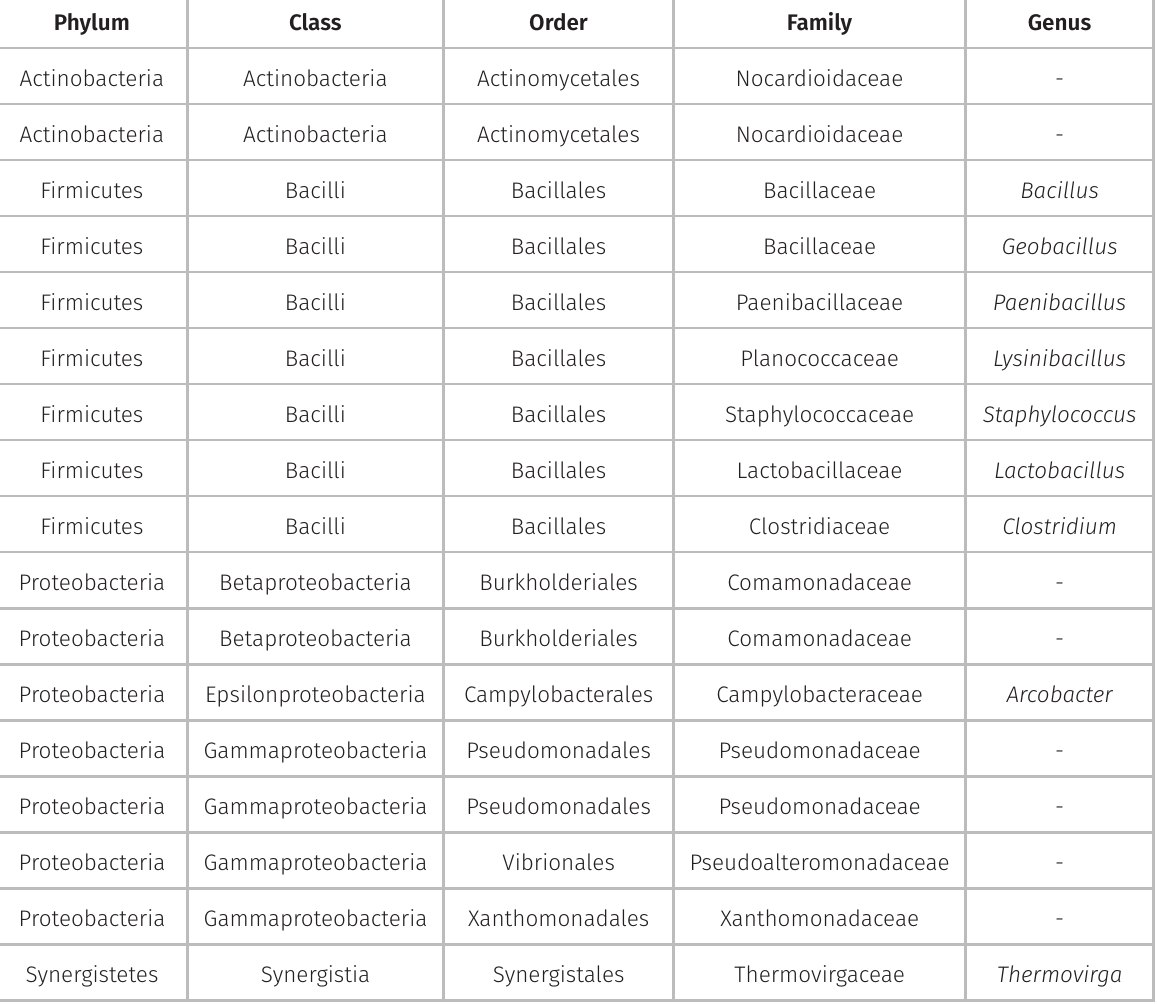
Table III. Common bacteria OTUs found in three EM inoculants